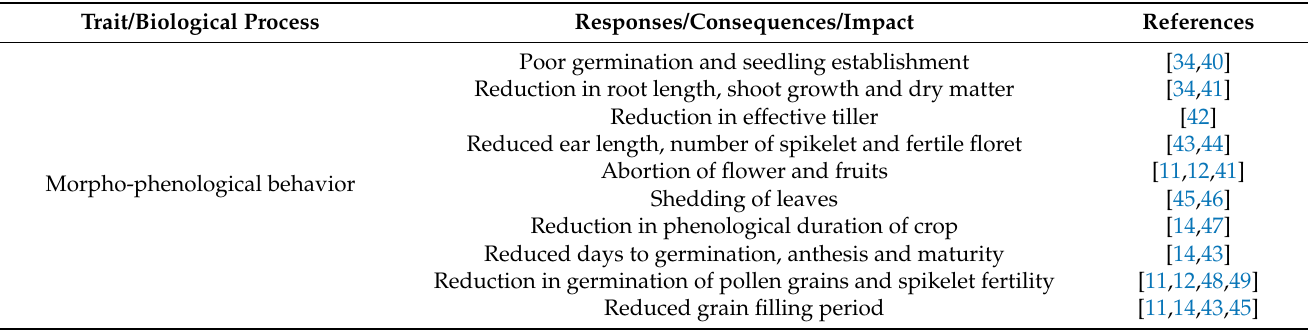
Table 2. Impact of heat stress on different traits/biological processes of wheat. Trait/Biological